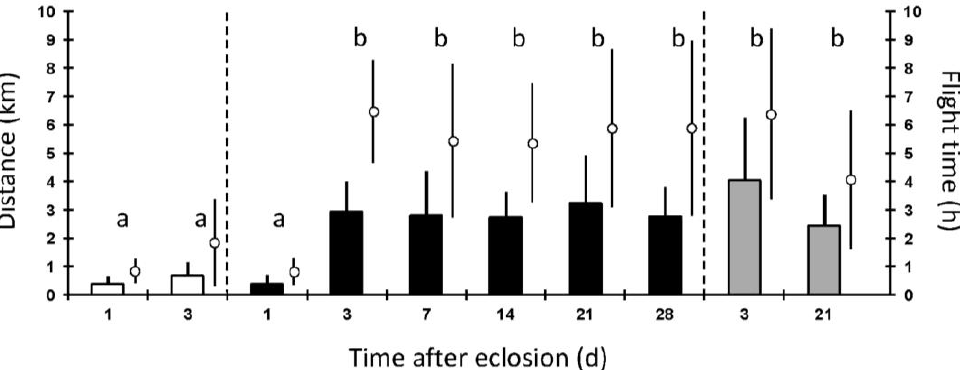
Figure 2. Total flight distances (bars) and average flight times (circles above the bars) for starved (water only; white bars), sugar-fed (10% fructose solution; black bars), and blood-fed (sugar-fed with a blood meal immediately before the experiment; grey bars) females of different ages. Data shown are means (±STDEV) from n = 14 (cid:177) 19 for each treatment recorded on flight mills (Oneway Anova, Tukey-HDS, p (cid:148)(cid:3)(cid:19)(cid:17)(cid:19)(cid:24) ; for distance and flight